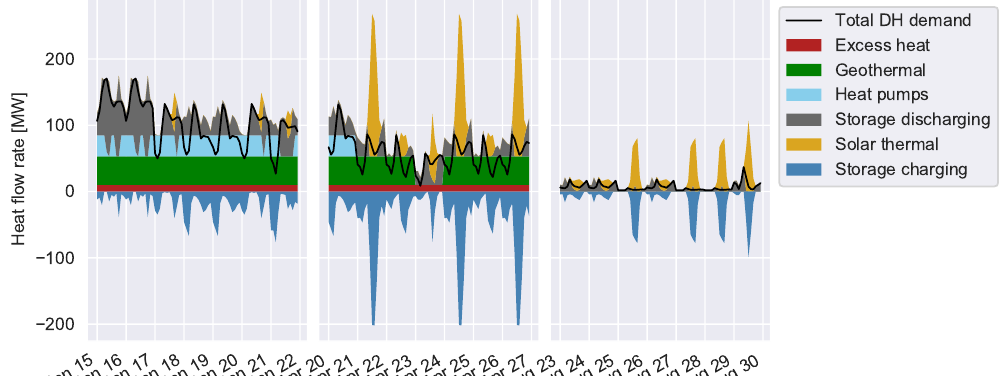
Figure 10. Detailed heating power plot of the minimum PEIS design for a winter, spring and summer